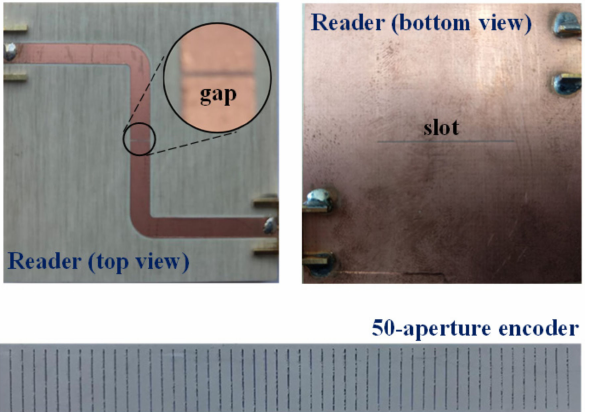
Figure 15. Photograph of the fabricated reader and encoder for the electromagnetic linear encoder system based on all-dielectric aperture encoders. Reprinted with permission from [25]. Copyright